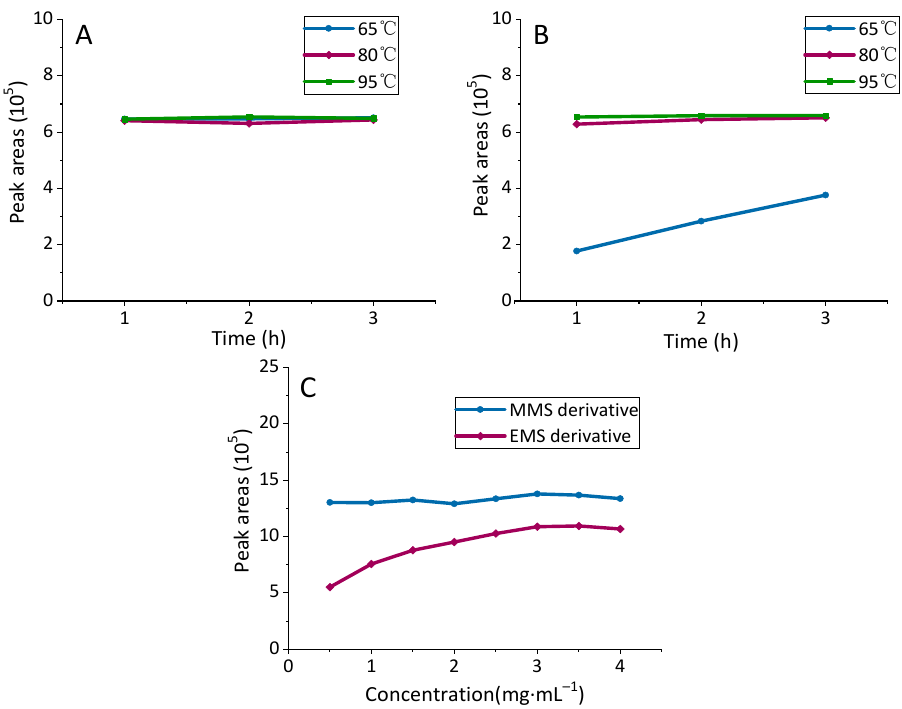
Figure 5. ( A ) Temperatures and times of the MMS derivatization reaction; ( B ) temperatures and times of the EMS derivatization reaction; ( C ) concentrations of the derivatization reagent.